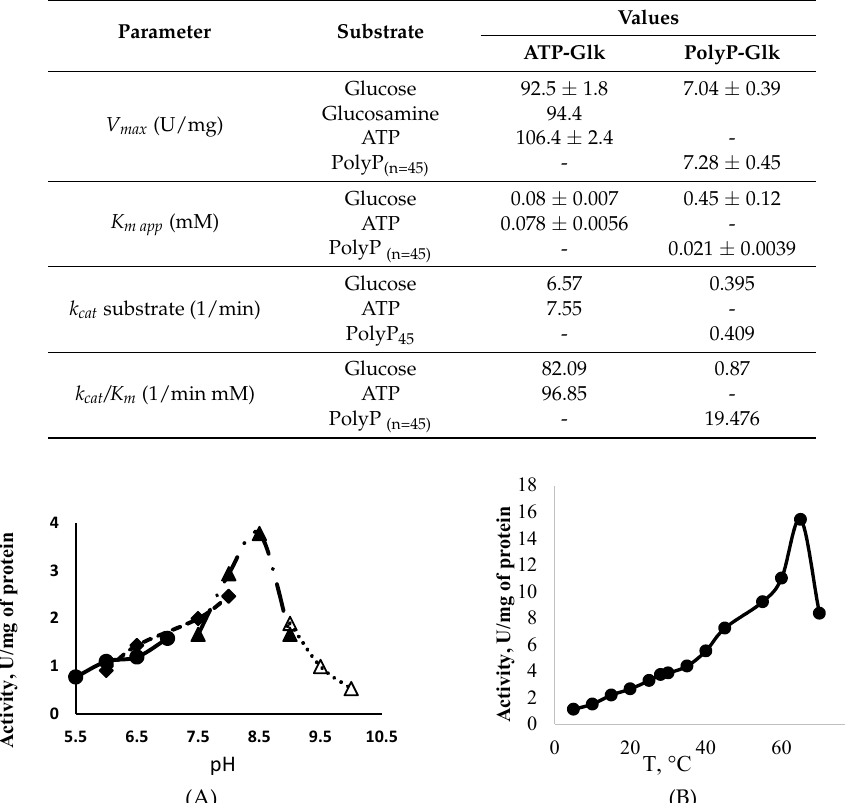
Figure 3. Effect of the temperature ( A ) and the pH ( B ) on the activity of polyphosphate-dependent glucokinase from Methylomonas sp . 12.